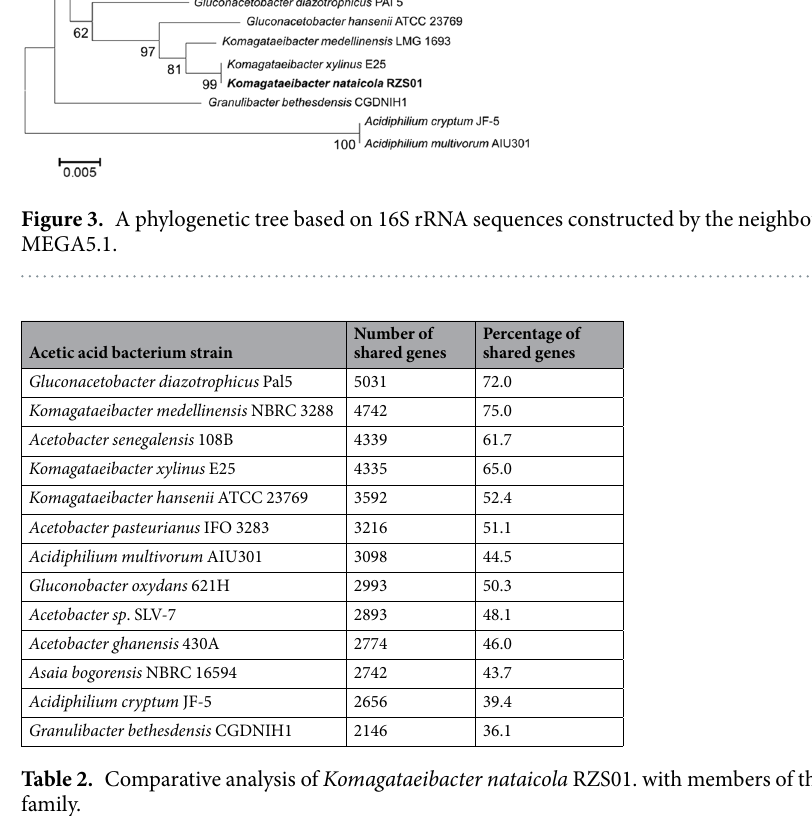
Table 2. Comparative analysis of Komagataeibacter nataicola RZS01. with members of the Acetobacteracea